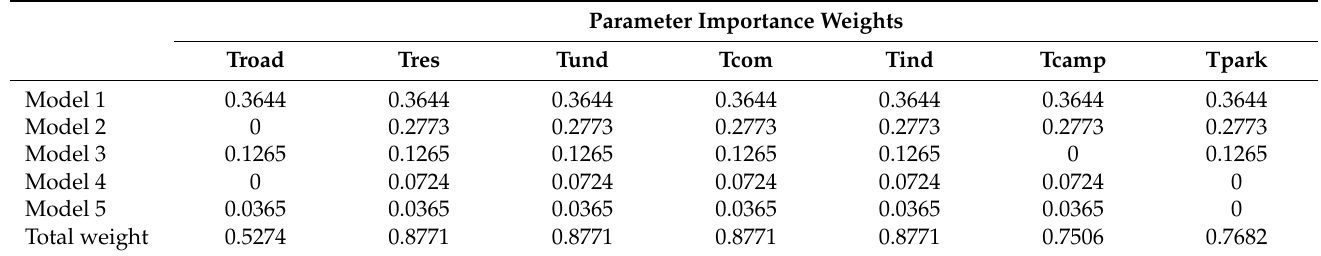
Table 4. Importance weights of parameters in the confidence set of candidate models for binary logistic regression analysis of the relationship between habitat attributes and visits to camera stations by San Joaquin kit foxes or red foxes in Bakersfield, California, during